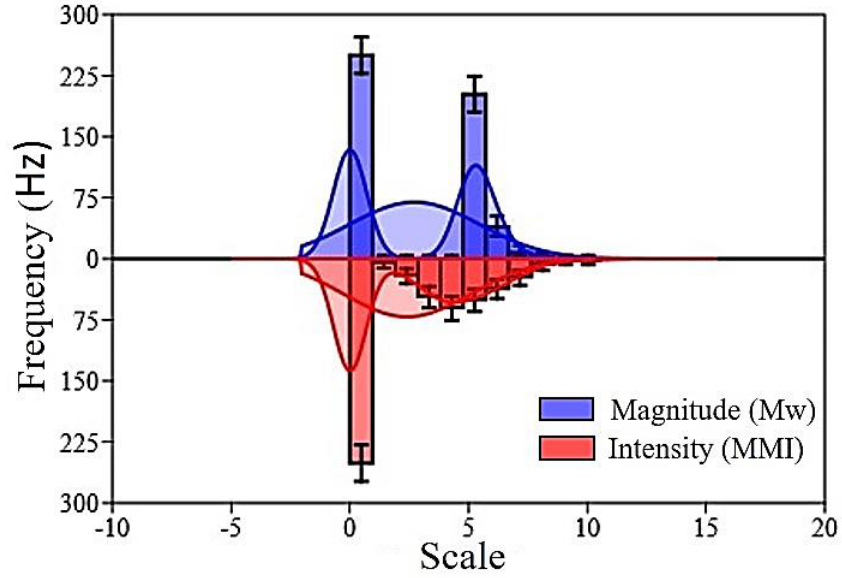
Figure 6. Bi-histogram of magnitude and intensity comparison using frequency that is used for probability assessment (Mw: moment magnitude, MMI: modified Mercalli intensity scale).